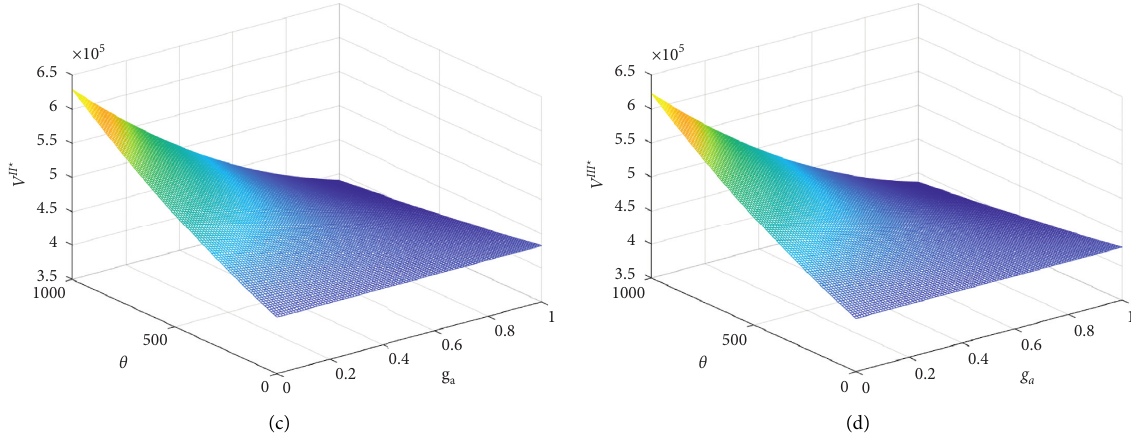
Figure 13: The effects of θ and g